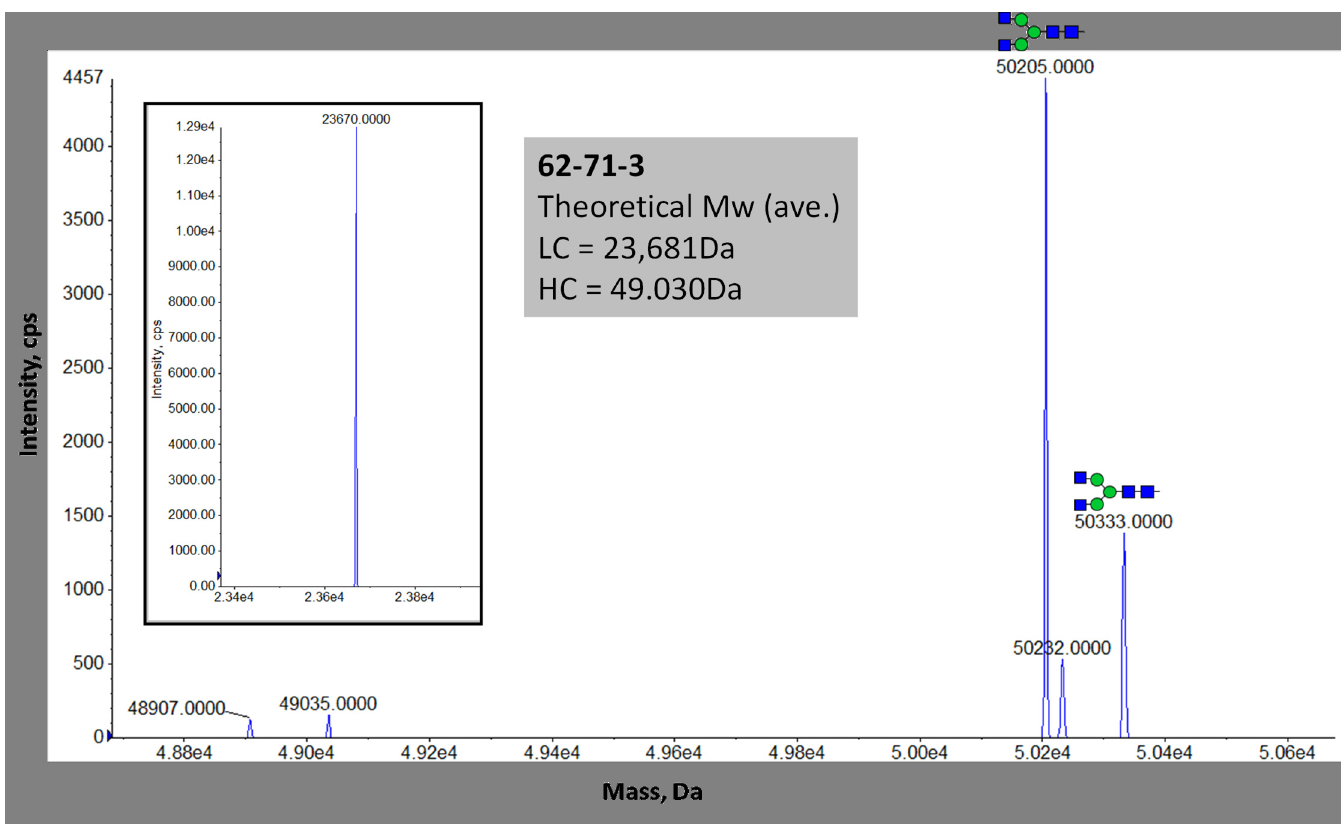
Fig 3. Deconvoluted spectrum of intact, reduced 62-71-3 HC. The inset shows the zoomed-in LC region with theoretical molecular weights for LC and HC indicated. Detected N-linked glycoforms are shown. The N-glycan nomenclature used was from www.proglycan.com.